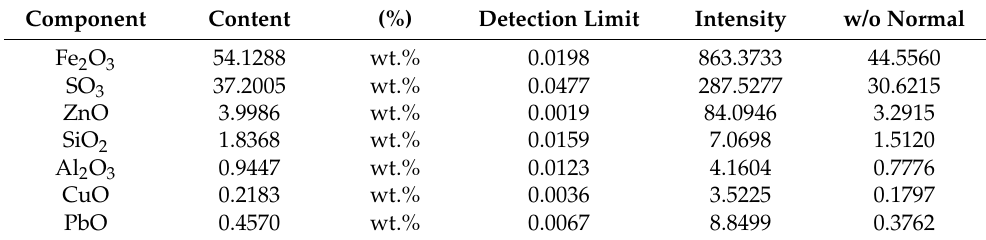
Table 1. XRF spectroscopy qualitative analysis.